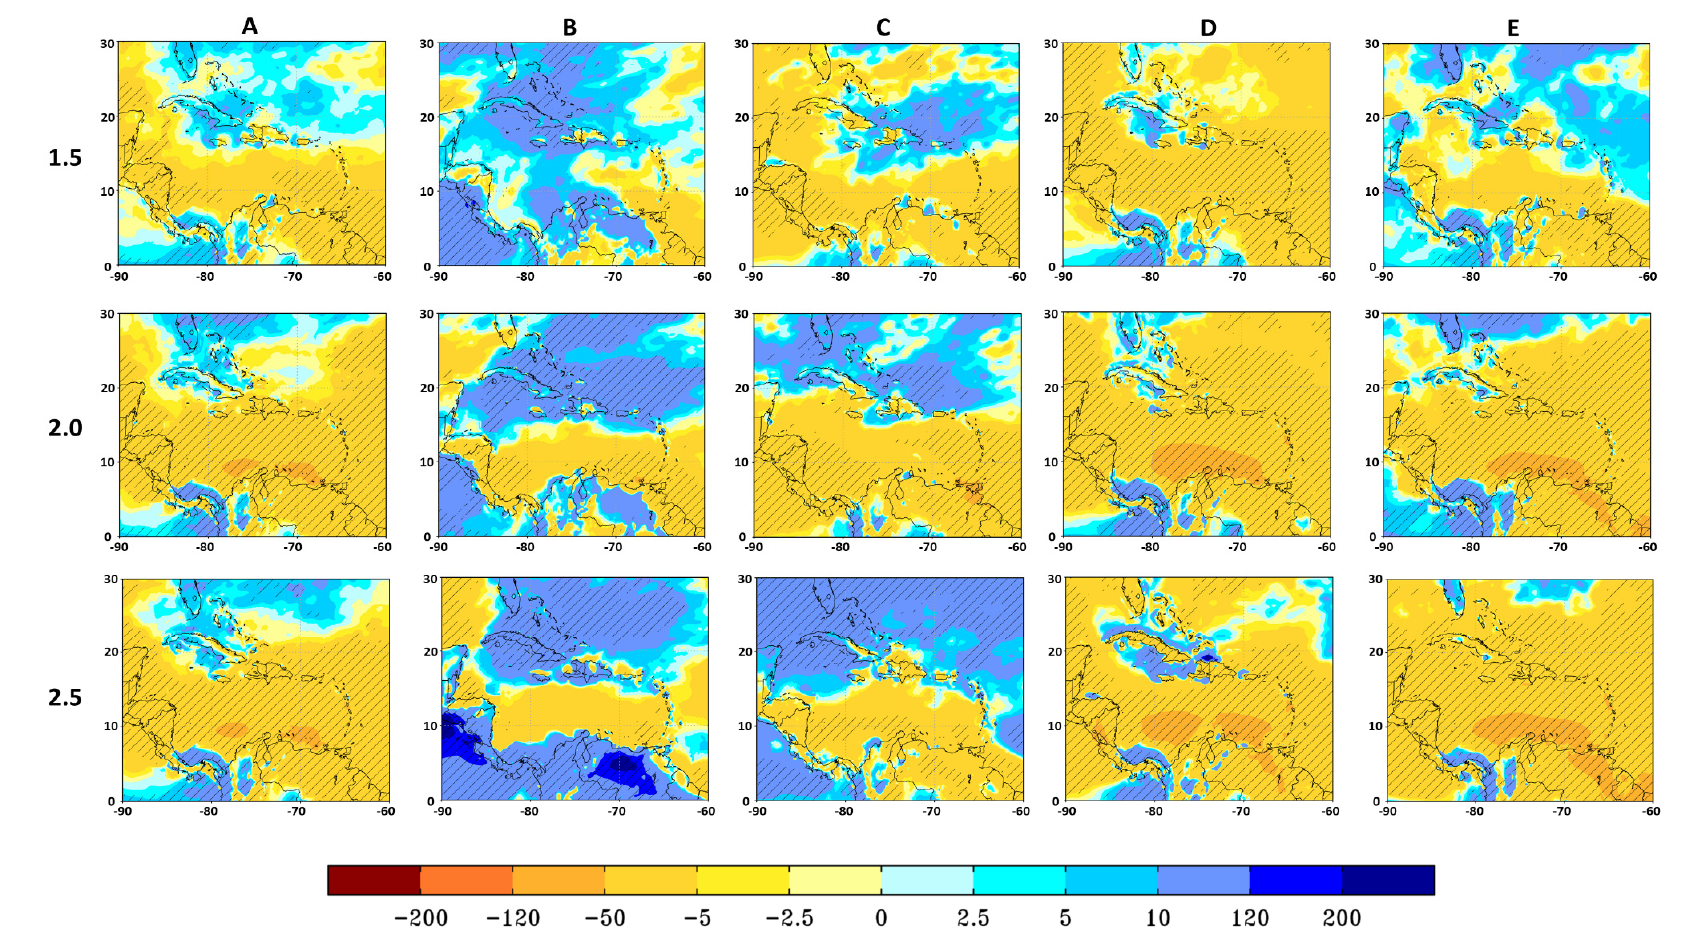
Figure 9. Diagram showing the projected percentage change in precipitation for (column A) Annual (column B) NDJ, (column C) FMA, (column D) MJJ, and (column E) ASO for the 1.5 °C (row 1), 2.0 °C (row 2), and 2.5 °C (row 3) global warming thresholds. Results are from the ensemble mean of six perturbed physics simulations of the PRECIS RCM. Hashing indicates changes that are at the 95% significance level. All changes are with respect to a baseline period of 1960–1990.